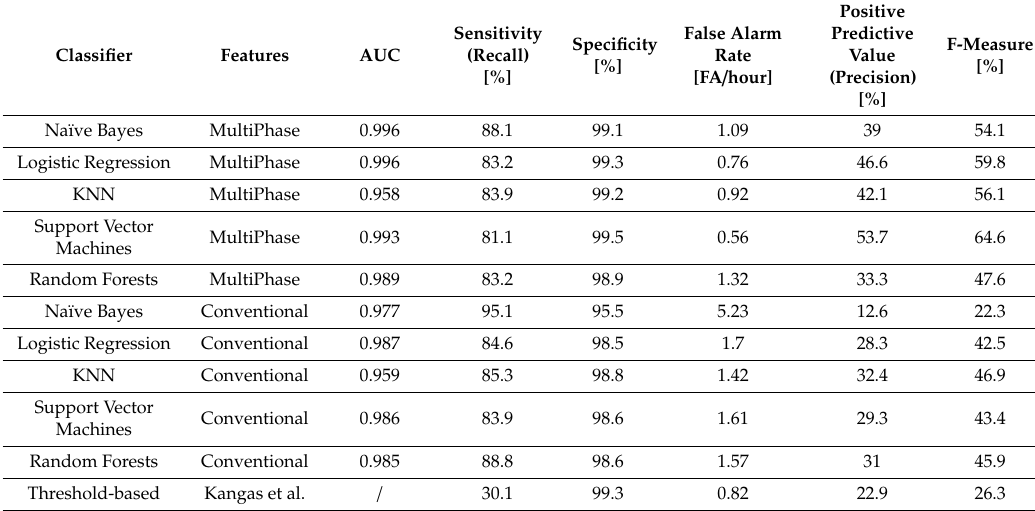
Table 2. Classification